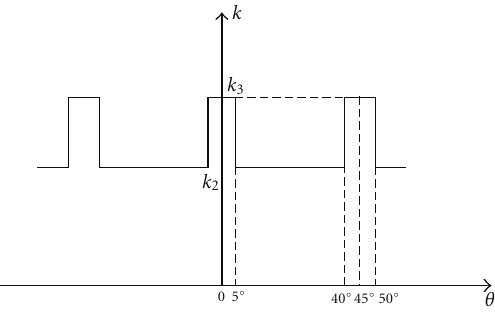
Figure 2: Changes of the mesh sti ff